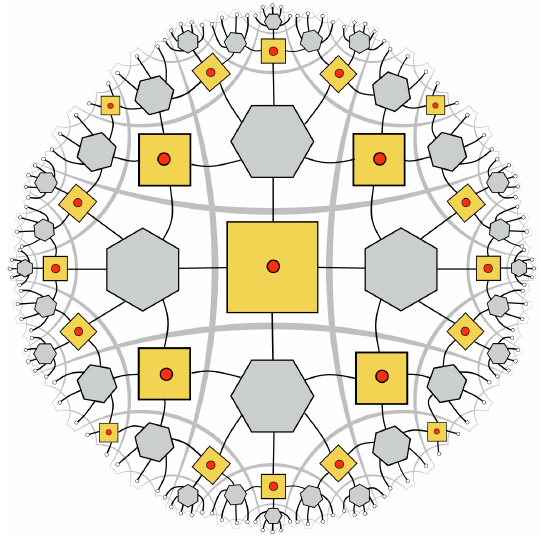
Figure 1. A tensor network representation of the hybrid holographic